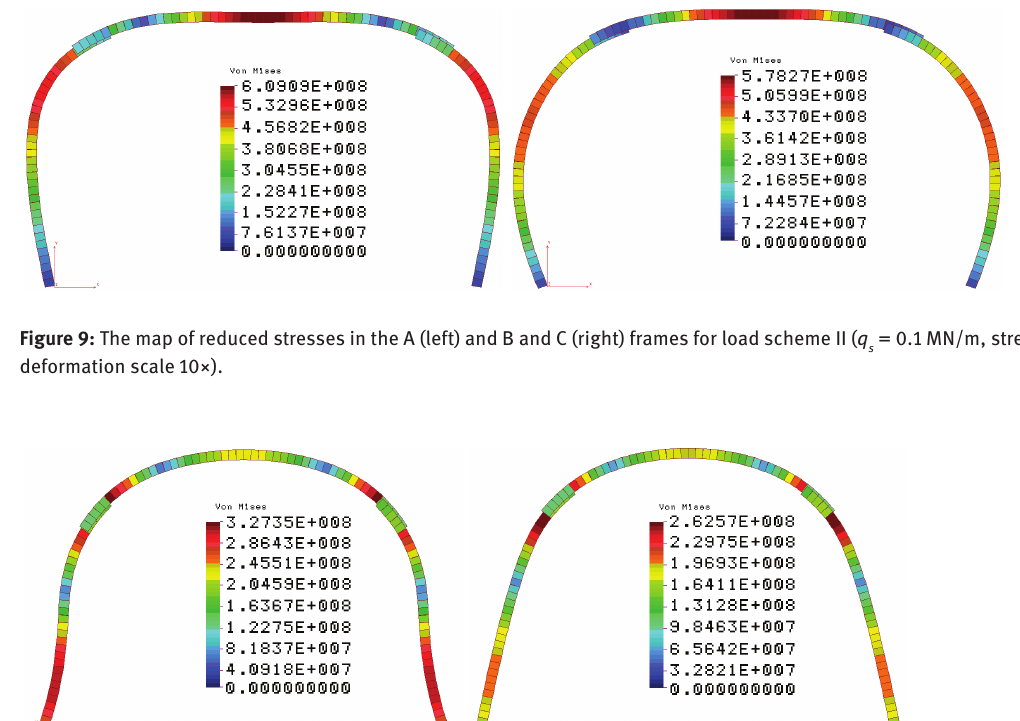
Figure 10: The map of reduced stresses in the A (left) and B and C (right) frames for load scheme III ( q deformation scale